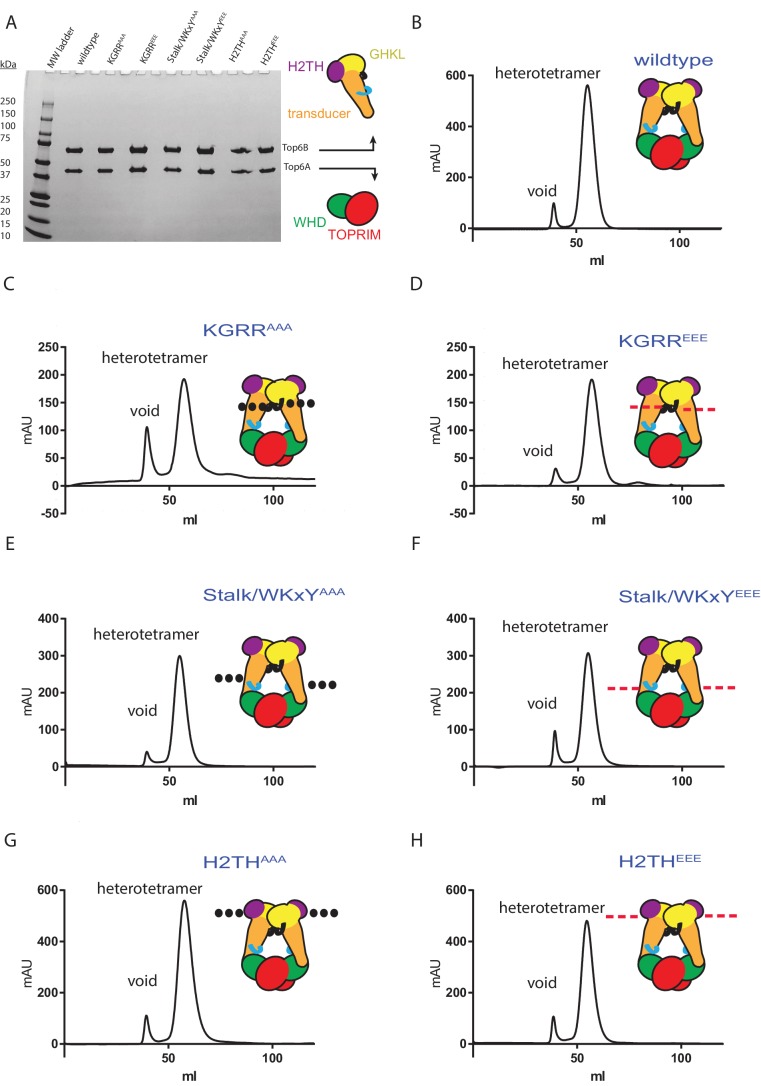
Topo VI functional mutants show similar solution properties to wild-type enzyme as judged by gel filtration.(A) Purity of constructs used in this study (Figures 1–2 and 4–7) was assessed by running ~4 μg of each construct on SDS-PAGE (4%–20% gradient) and staining with coomassie blue. Molecular weight standards (left) and subunit identity (right) are labeled. (B–H) Size exclusion chromatographs for wild type (B), KGRRAAA (C), KGRREEE (D), Stalk/WKxYAAA (E), Stalk/WKxYEEE (F), H2THAAA (G), and H2THEEE (H) topo VI constructs. Void and heterotetramer peaks are noted for each chromatograph. The placement and nature of mutations in each construct are depicted in the cartoons above each chromatograph (‘•••' - AAA; ‘---' – EEE). Each protein preparation gives rise to a monodisperse peak eluting at the same expected volume.